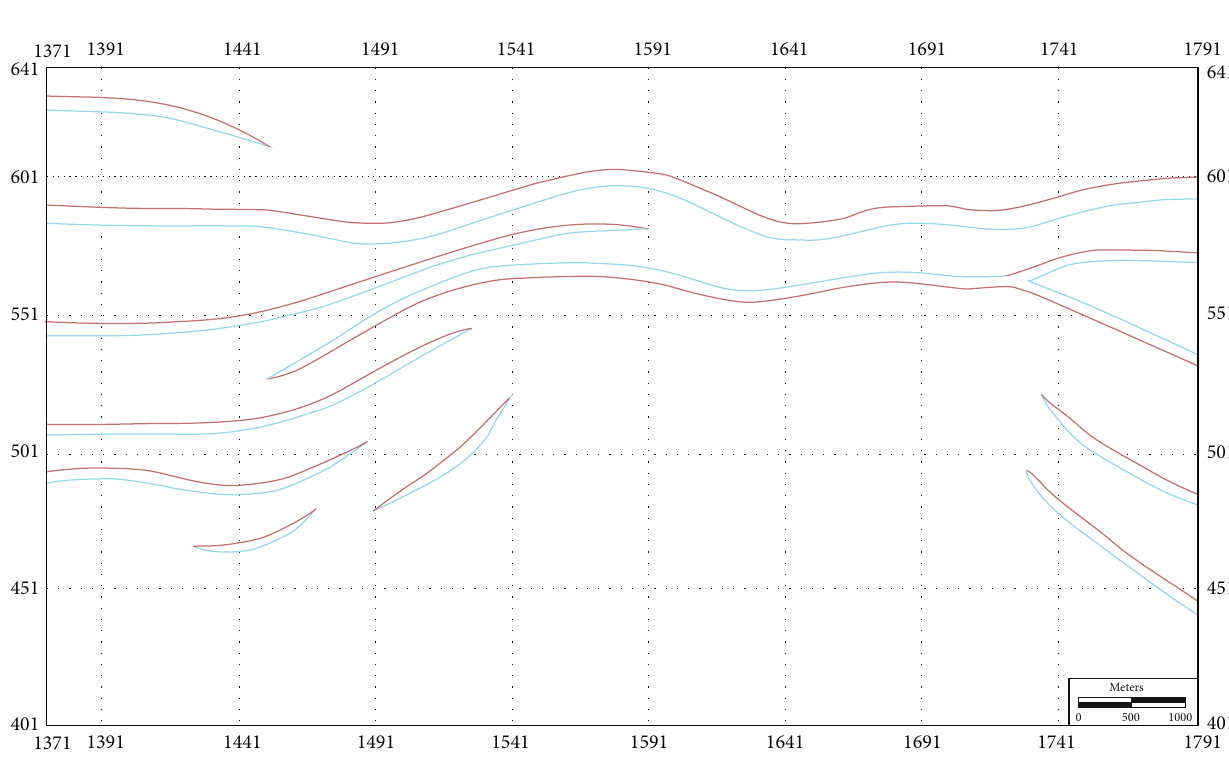
Figure 4: T1 re fl ector plane fracture